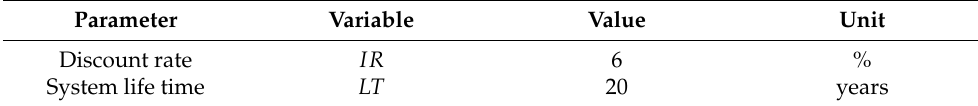
Table 2. HREM financial parameters.